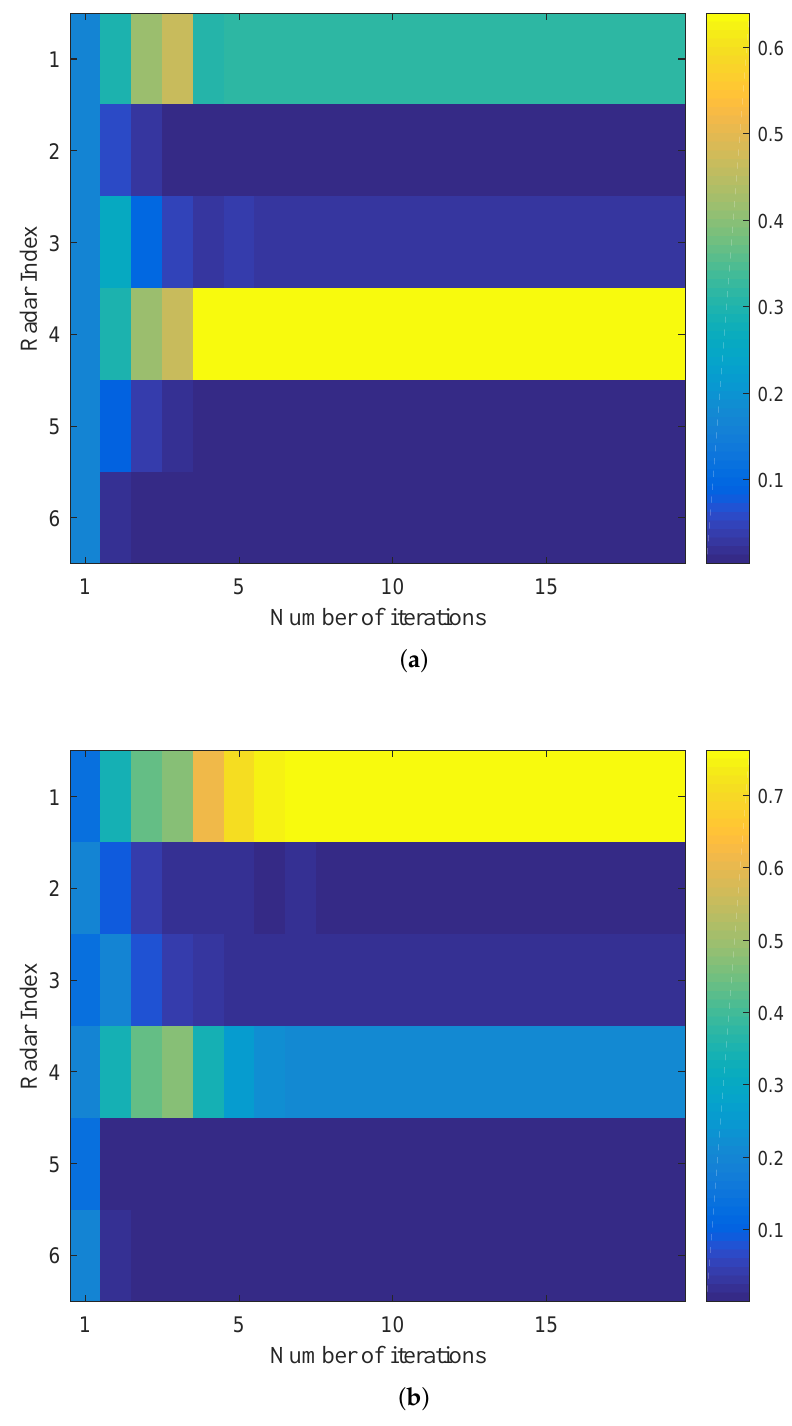
Figure 5. Convergence behavior for the transmit power allocation in the second case: ( a ) Target position is [ 0,0 ] km; ( b ) Target position is [ − 30, − 40 ]